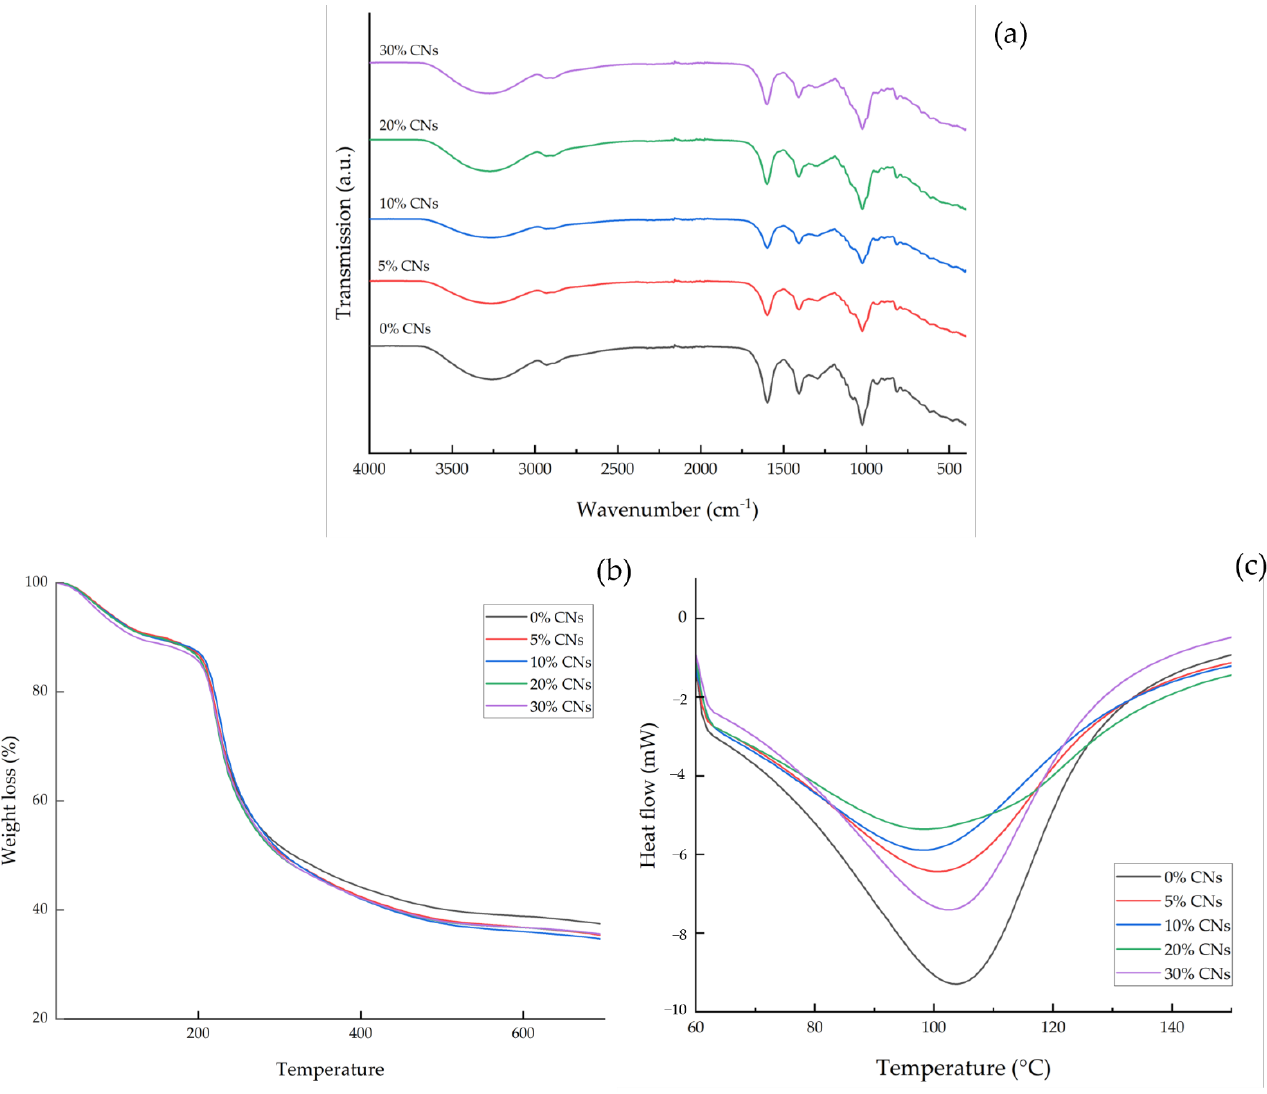
Figure 2. FTIR spectra ( a ), TGA ( b ), and DSC thermograms ( c ) of smart bilayer films incorporating different concentrations of cellulose nanosphere (CNs).